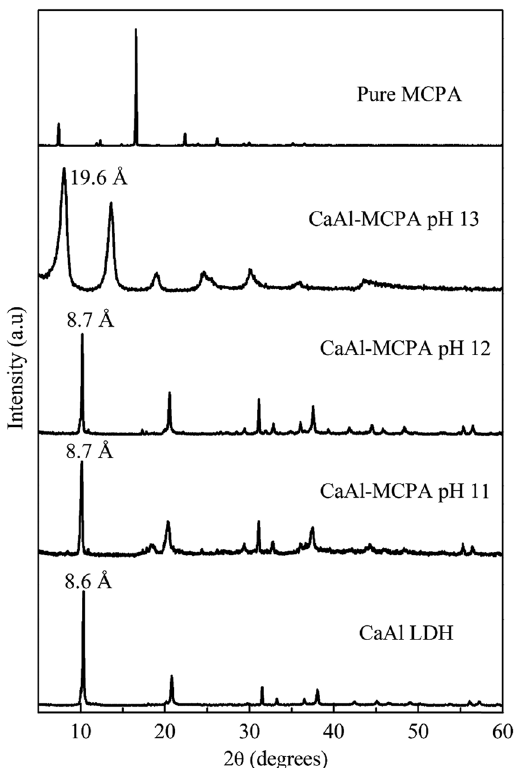
Figure 2: PXRD patterns of CaAl LDH host and its nanocomposites at various